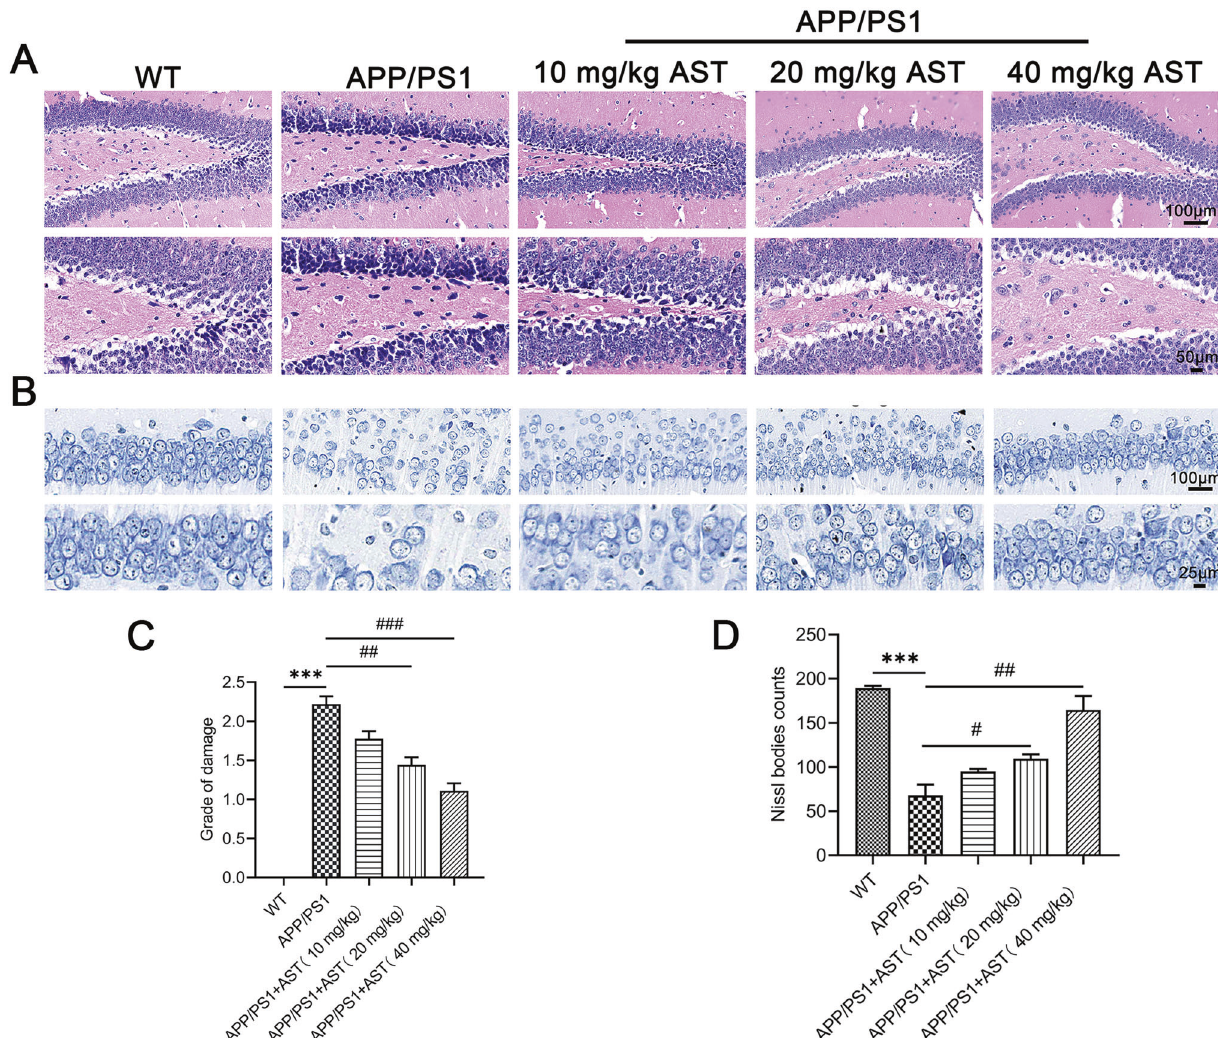
Fig. 2 AST reduced hippocampal neuronal damage of APP/PS1 mice by HE and Nissl staining. A HE staining aimed to observe the alterations of neuronal morphology in mice hippocampus. Scale bar = 100, 50 μ m, respectively. B Nissl staining aimed to detect changes in the morphology of Nissl bodies in the mice hippocampus. Scale bar = 100, 25 μ m, respectively. C The grade of neuronal damage in the hippocampus of mice. D Statistical analysis of the Nissl bodies in the hippocampus of mice. Data were presented as mean ± SD, n = 4/group. *** p < 0.001 vs WT group, # p < 0.05 and ## p < 0.01 vs APP/PS1 group. protein interaction network and found that there were cells. Compared with the control group, the expressions of interactions between PI3K/Akt-mTOR pathway-related proteins LC3BII, Beclin-1, and LAMP-1 were decreased and the expres- and proteins regulated autophagic fl ux (Fig. 8A) (Source: 9 sion of p62 was increased in HT22 cells damaged by A β 25-35 items (mouse)-STRING interaction network (string-db.org)). (Fig. 7A – F). While administration of DNP and AST up-regulated Then, we further evaluated the effect of AST on the PI3K/Akt- the expressions of LC3BII, Beclin-1, and LAMP-1 and suppressed mTOR pathway. As shown in Fig. 8, the ratios of p-PI3K/PI3K, p- the expression of p62 in A β 25-35-damaged HT22 cells Akt/Akt, and p-mTOR/mTOR in A β 25-35-injured HT22 cells were (Fig. 7A – F). However, when AST-treated AD cell models were cotreated with autophagy inhibitors 3-MA or ba fi lomycin A1 (Baf A1), the ratio of LC3BII/LC3BI and the expressions of Beclin- 1 and LAMP-1 were signi fi cantly reduced (Fig. 7B, C, E – H, J, K) while the expression of p62 was signi fi cantly increased (Fig. 7B D, G, I). These above results suggested AST activated autophagy and regulated the expression of autophagic fl ux- associated proteins.